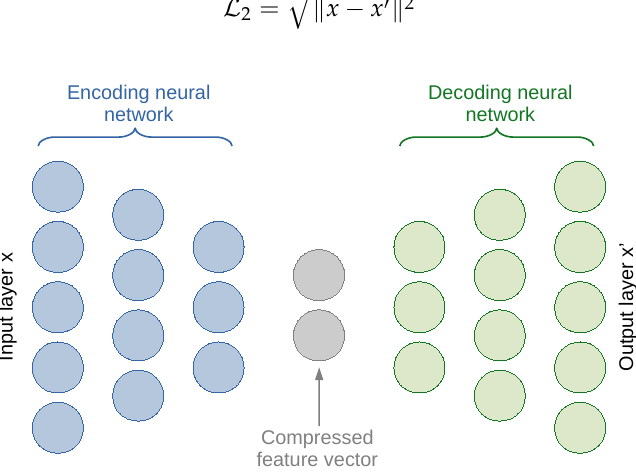
Figure 2. Generic architecture of an autoencoder learning a compressed representation of benign network